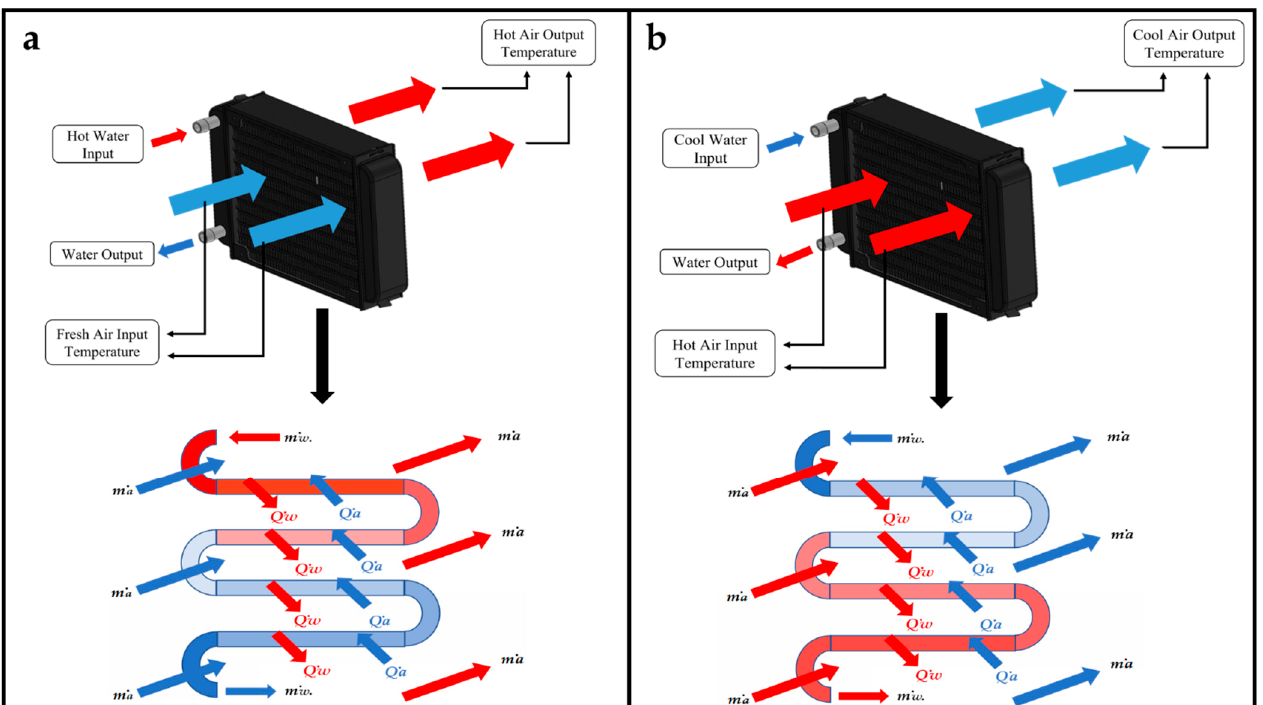
Figure 3. Schematic of heat exchangers for heating ( a ) and cooling ( b ).